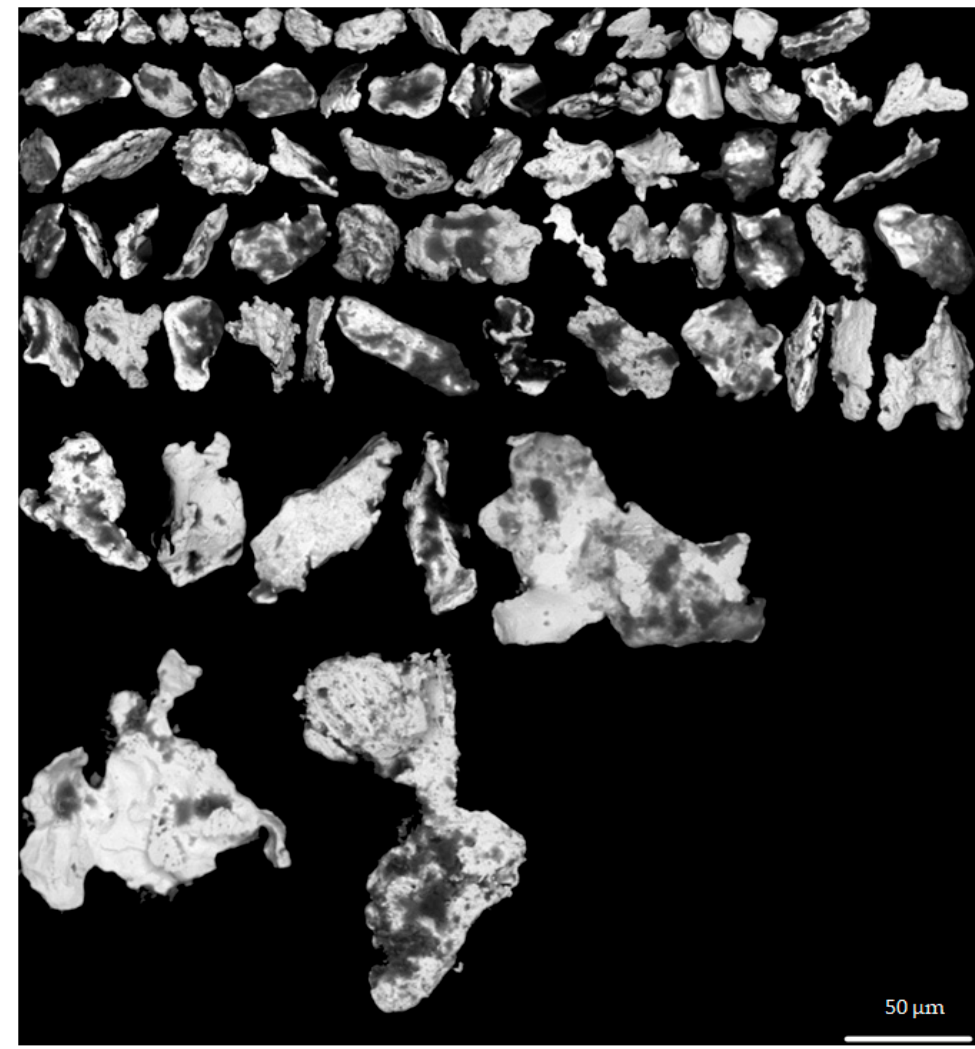
Figure 7. Example of a mosaic of “remobilized” grains generated automatically from a small glacial sediment survey from northern Abitibi, Québec. The shape classification has been performed with a CNN routine (ARTMorph).